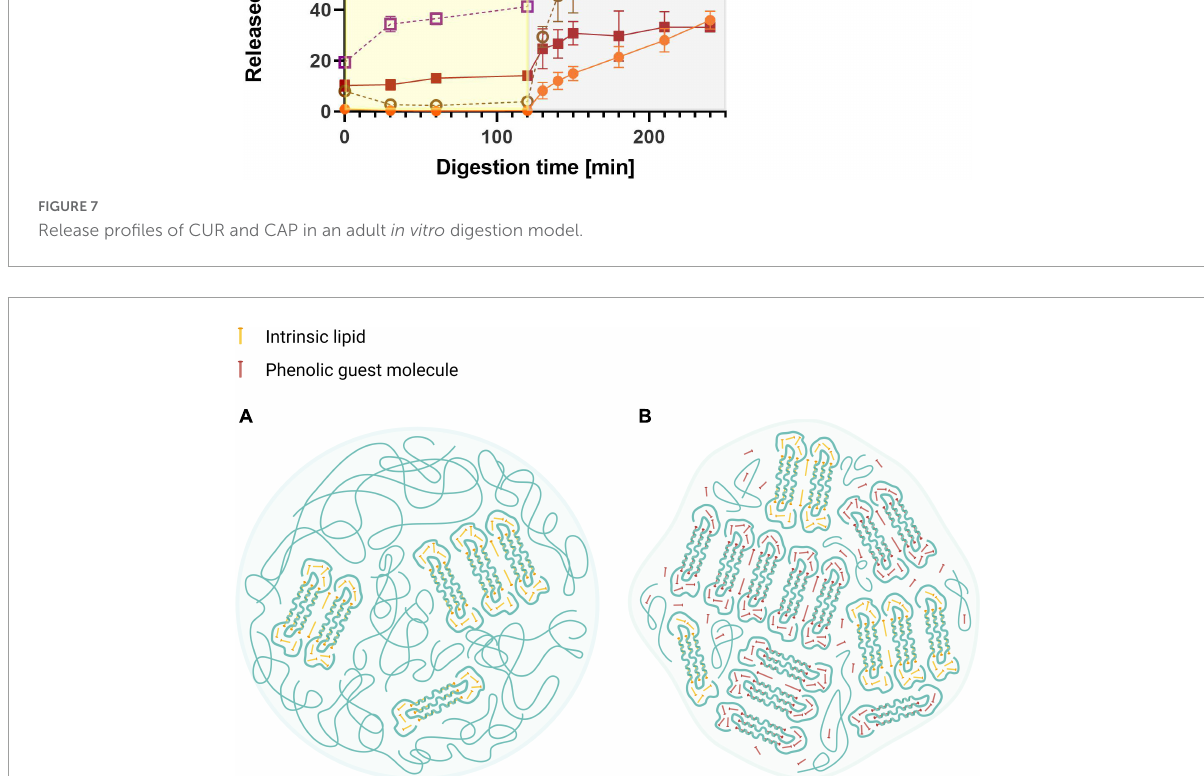
FIGURE8 Schematic illustration of HACS particulate architectures in which crystalline V-amylose assemblies are interspaced by amorphous regions of amylose and amylopectin. (A) HACS colloid entrapping intrinsic moieties (marked as yellow rods). (B) HACS colloid entrapping intrinsic moieties (marked as yellow rods) and the encapsulated phenolic guest molecules (marked as red rods). Such colloids may further aggregates to form larger entities. Created with